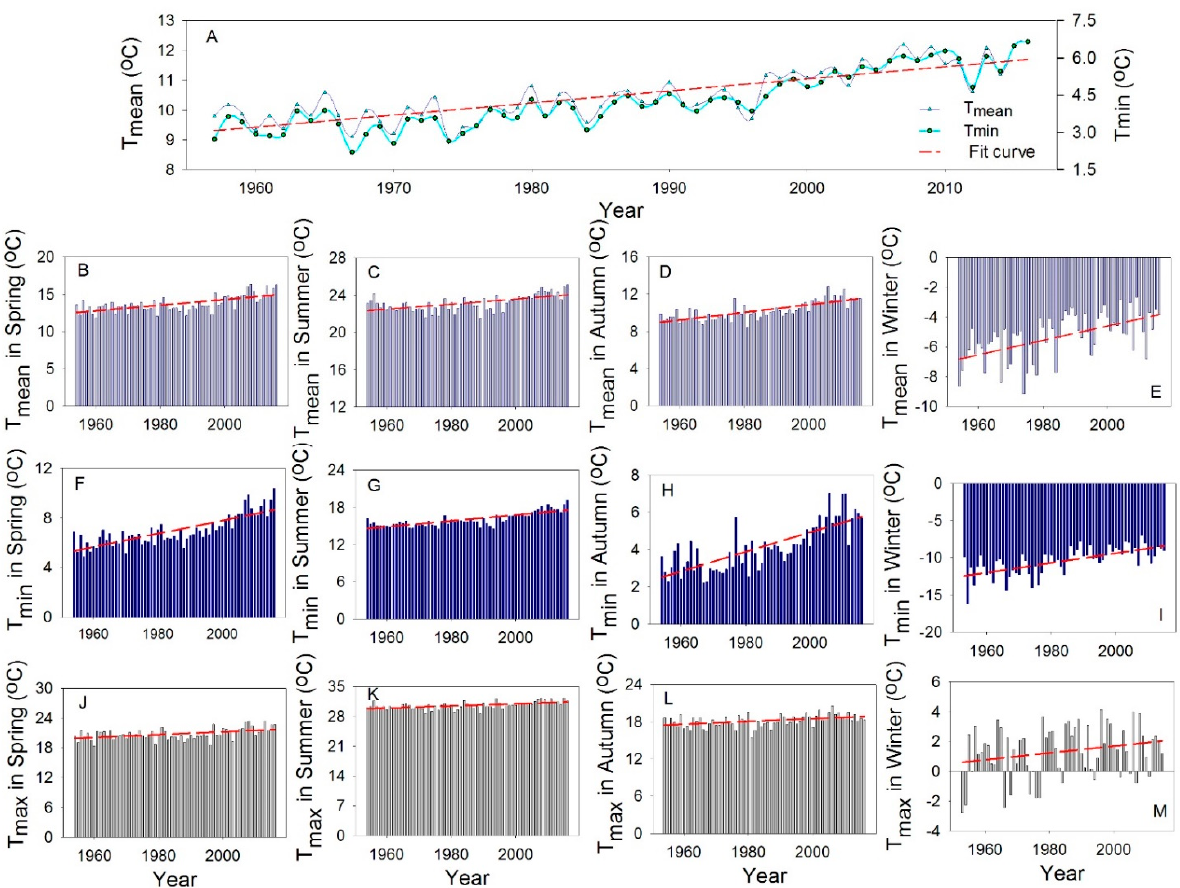
Figure 7. Changes of annual mean and minimum temperature ( A ), and mean ( B – E ), minimum ( F – I ), maximum ( J – M ) temperature in seasons from 1957–2017 in the study